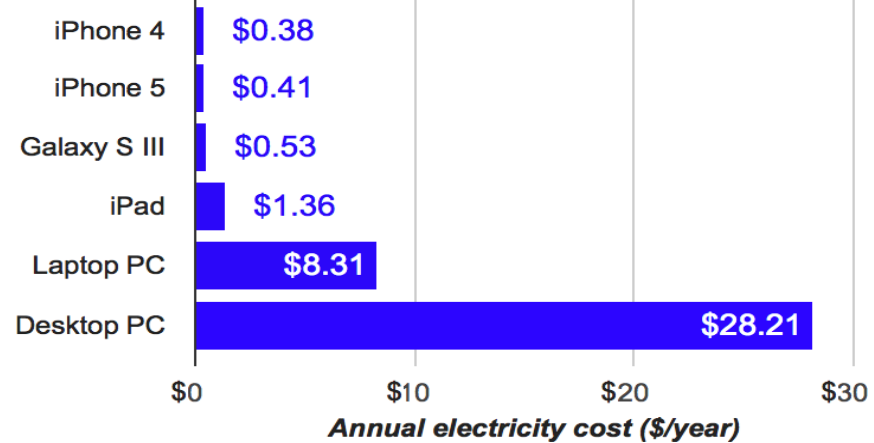
Figure 14. The rapid disruption—from desktops to laptops to tablets and smart phones [37].